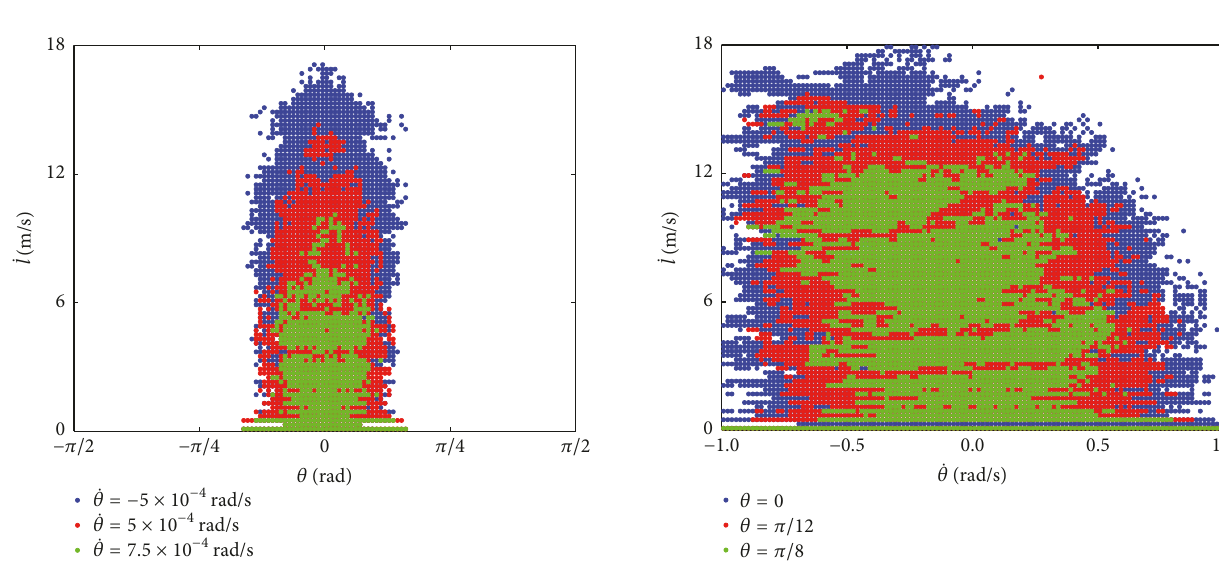
Figure 14: Effect of tangential velocity on the parameter domain. Figure 15: Effect of pitch angle on the parameter